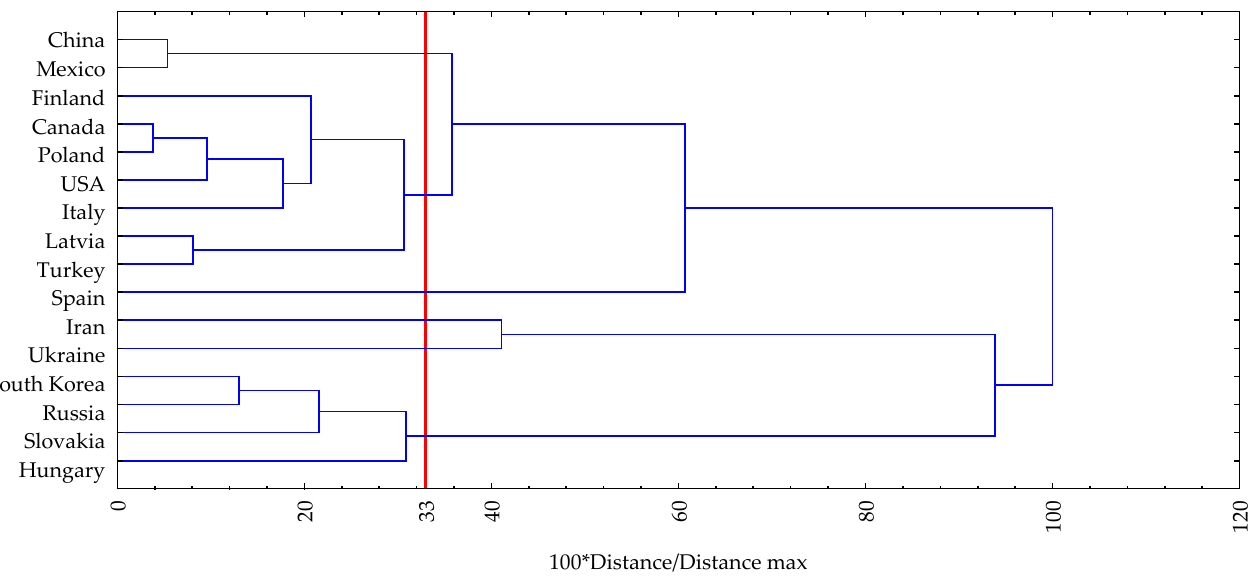
Figure 17. Cluster analysis for the main chemical compounds in dendromass in selected countries.